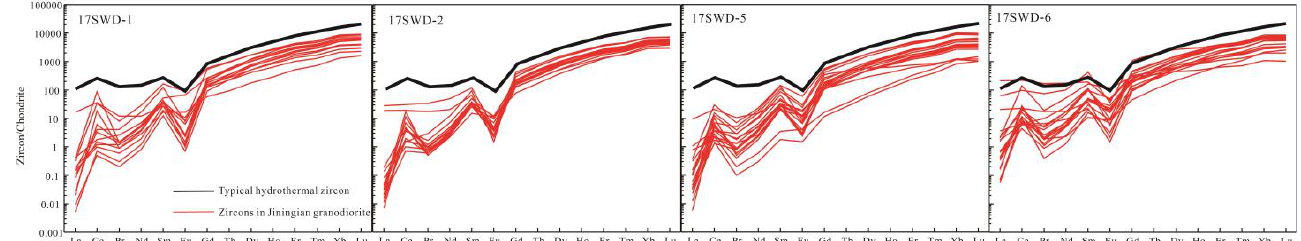
Figure 10. Chondrite-normalized REE patterns for different zircon samples in the Dahutang deposit. Chondrite values are from [53], and typical zircon is from [47].